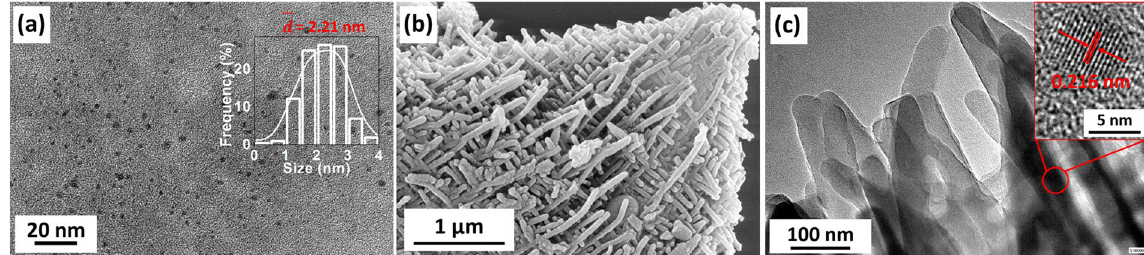
Figure 2. ( a ) TEM image of CDs (the inset is the particle size histogram of CDs); ( b ) SEM image of CDs@ Mat-PANI; ( c ) HRTEM image of the brim nanofibers of CDs@Mat-PANI (the inset is a magnified image of an individual CD encapsulated within Mat-PANI nanofiber).